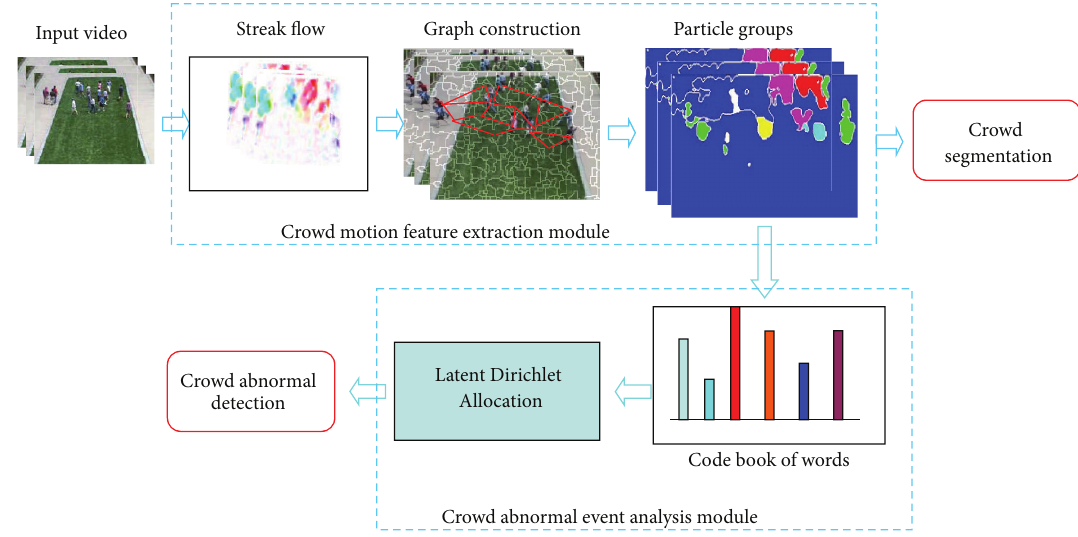
Figure 1: Flow chart of the proposed crowd motion analysis